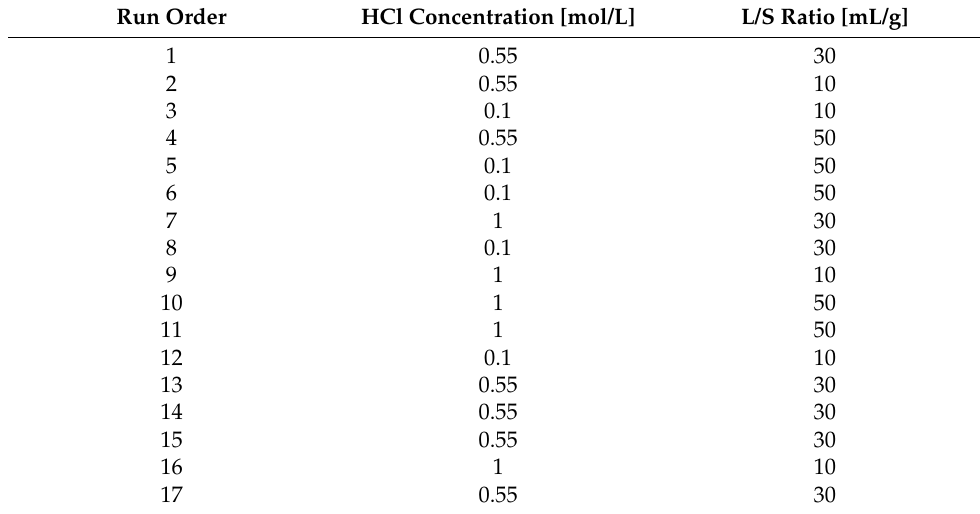
Table 1. Experimental design for P and Zn extraction with hydrochloric